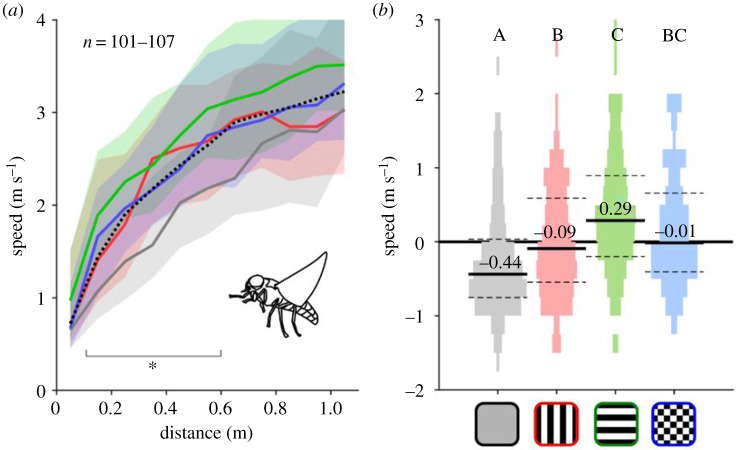
Approach speed of flies to each rug type. (a) Speed versus distance during fly approach, colour coded according to (b). Black dotted line is the median approach speed for the whole dataset. Shaded areas are the 25th and 75th percentile ranges. Star indicates the range over which grey significantly differs from the patterned rugs (Kruskal–Wallis multi-compare post hoc with Bonferroni correction, p < 0.05). See electronic supplementary material, table S1 for more statistics. (b) Approach speed relative to overall median. See figure 2 for graph conventions.